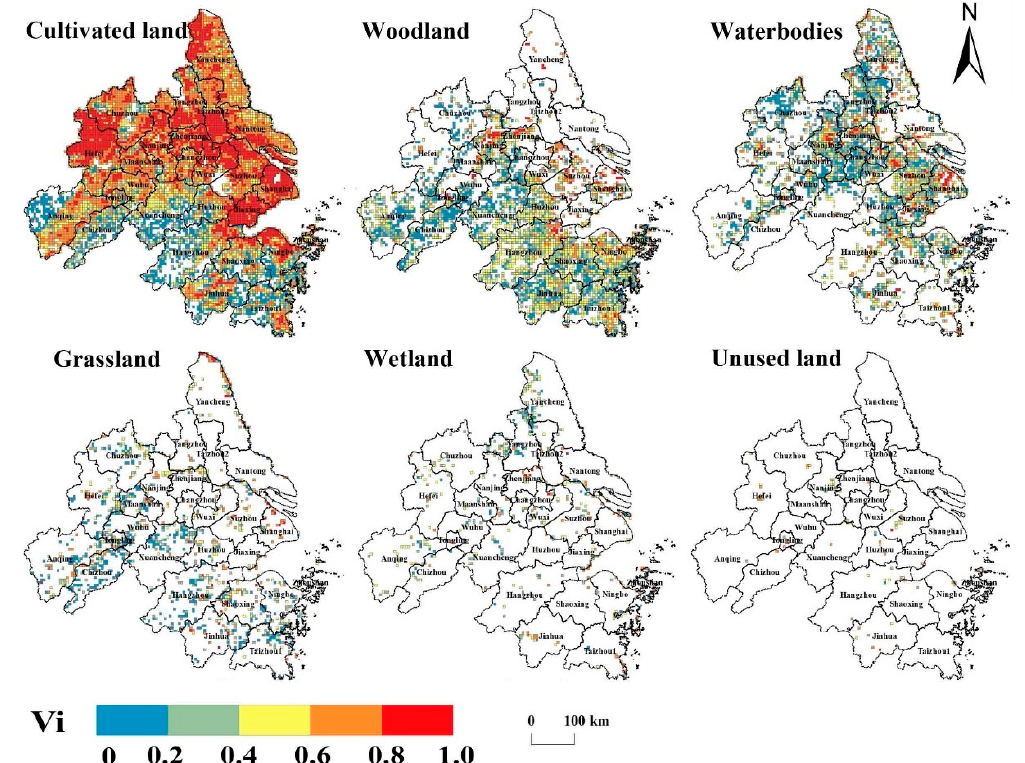
Figure 3. The spatial variation of V i at the 5 km-grid scale for each natural landscape in the YRD in 2015. The white grid cells indicate there was no common edge between the urban landscape and corresponding natural landscape.